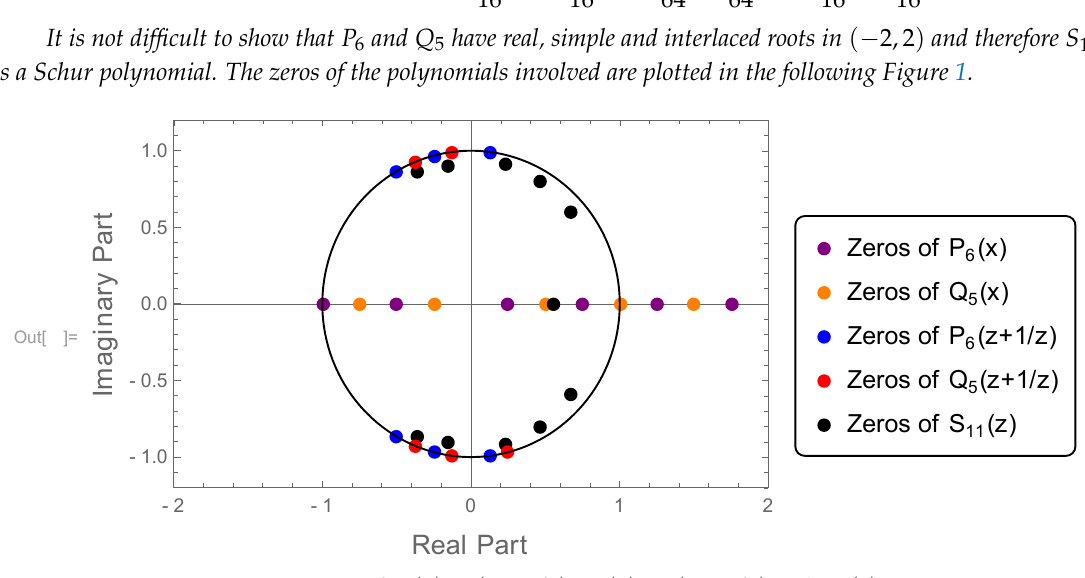
Figure 1. Zeros of P 6 ( x ) , P 6 ( z + 1/ z ) , Q 5 ( x ) , Q 5 ( z + 1/ z ) and S 11 ( z )